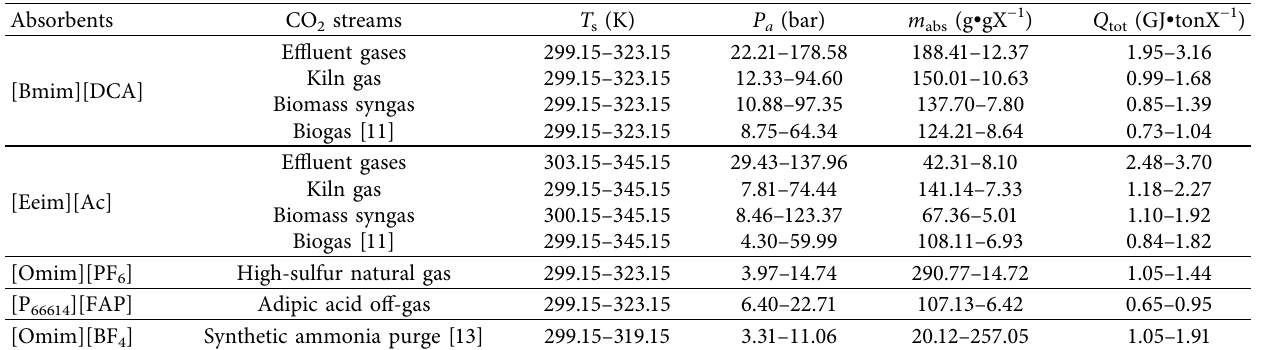
s , P a ), the absorbent amounts ( m abs ), and the energy consumption ( Q tot ) of the commercial absorbents.